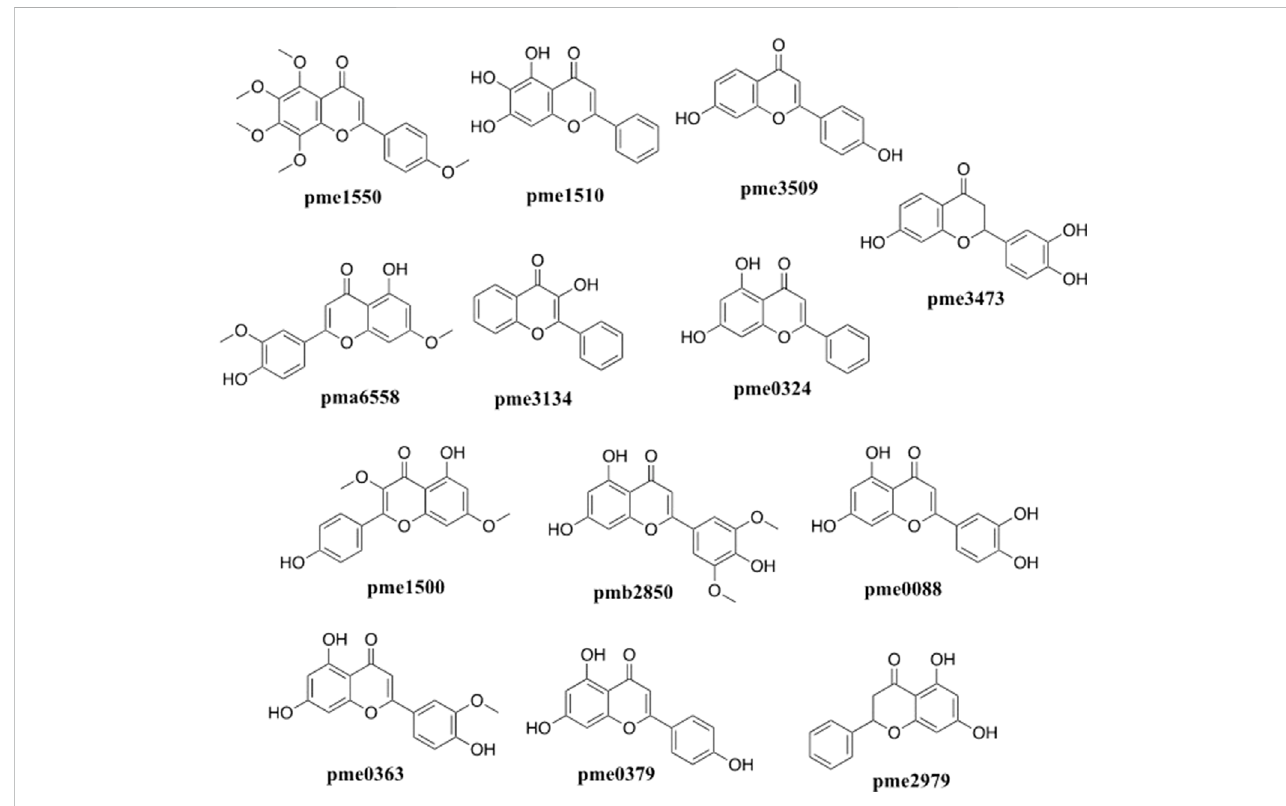
FIGURE 5 Chemical structures of the potential fl avonoids compounds of C. paliurus with anti-liver cancer effects screened by network pharmacology analysis.